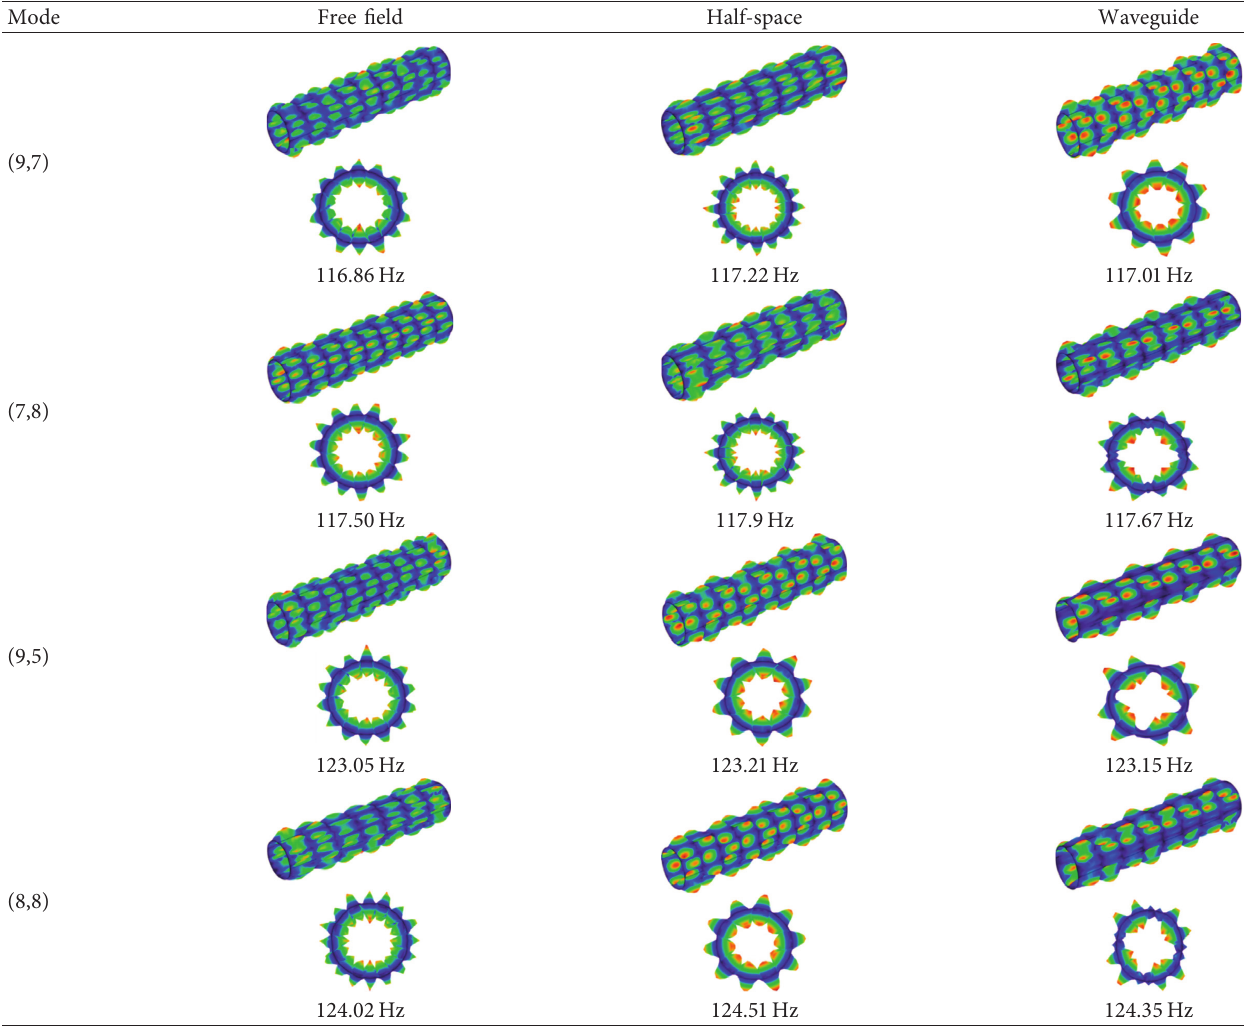
Table 2: Comparison for the modal frequencies and the mode shape of four modes around 120Hz in free field, half-space, and a Pekeris